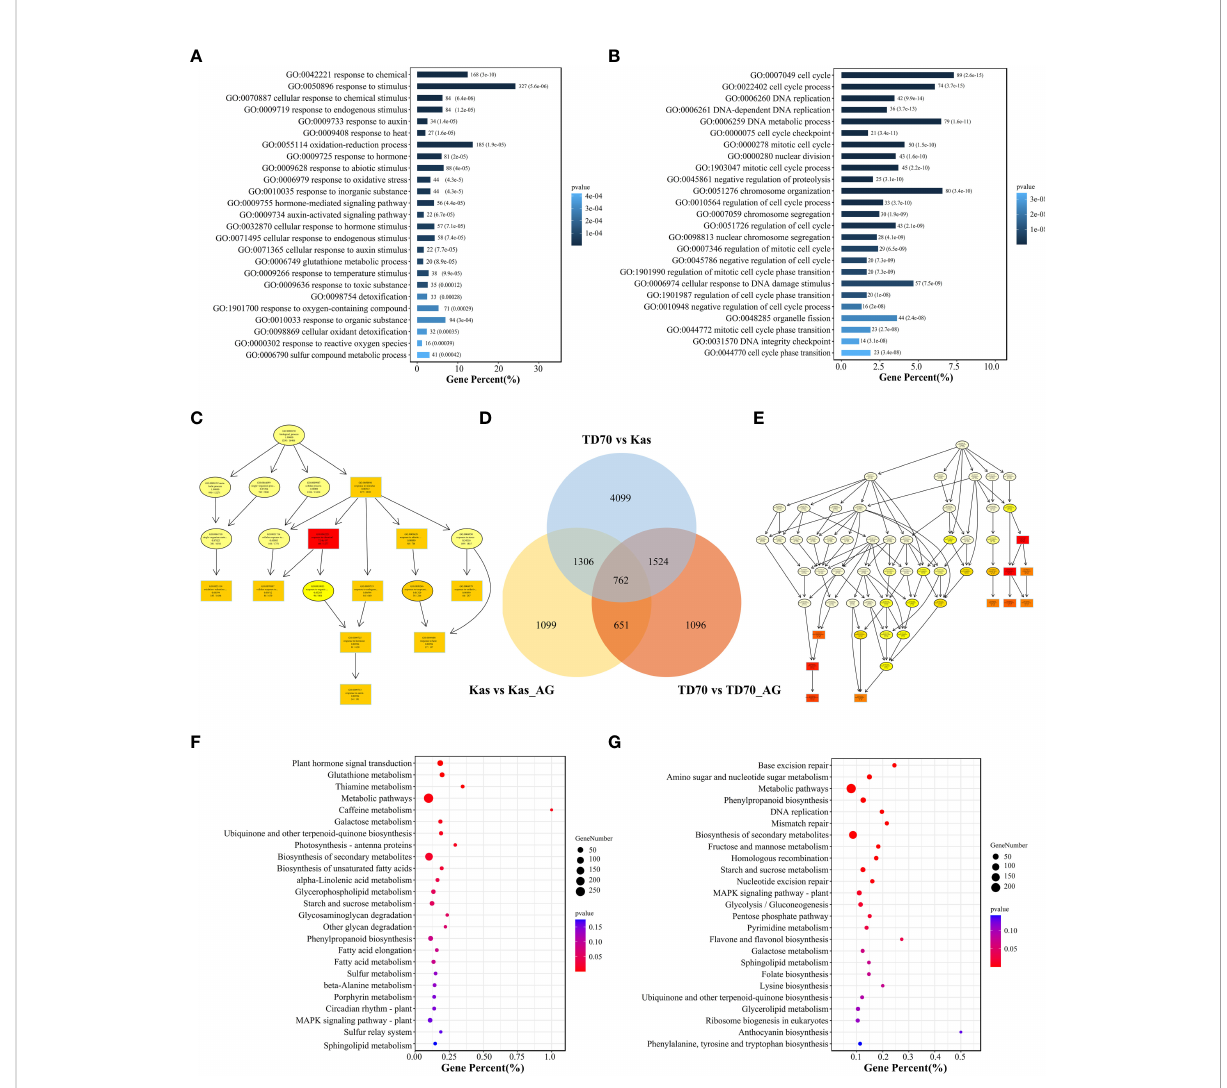
FIGURE 5 Transcriptome analysis of TD70 and Kasalath with/without AG treatment. (A) GO enrichment plot of TD70-speci fi c DEGs response to AG treatment. (B) GO enrichment plot of Kasalath-speci fi c DEGs response to AG treatment. (C) Biological process graphic result of TD70-speci fi c DEGs. (D) Venn plot of DEGs among three groups: TD70 vs Kas, Kas vs Kas_AG and TD70 vs TD70_AG. (C, E) Biological process graphic result of Kasalath-speci fi c DEGs. (F) KEGG enrichment plot of TD70-speci fi c DEGs response to AG treatment. (G) KEGG enrichment plot of Kasalath- speci fi c DEGs response to AG